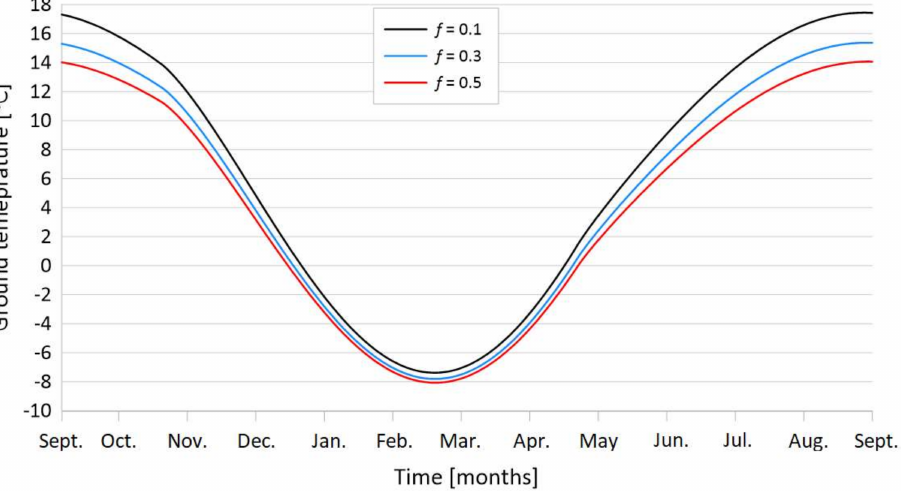
Figure 8. Influence of the evaporation rate coefficient on the ground temperature at the depth of the heat exchanger’s